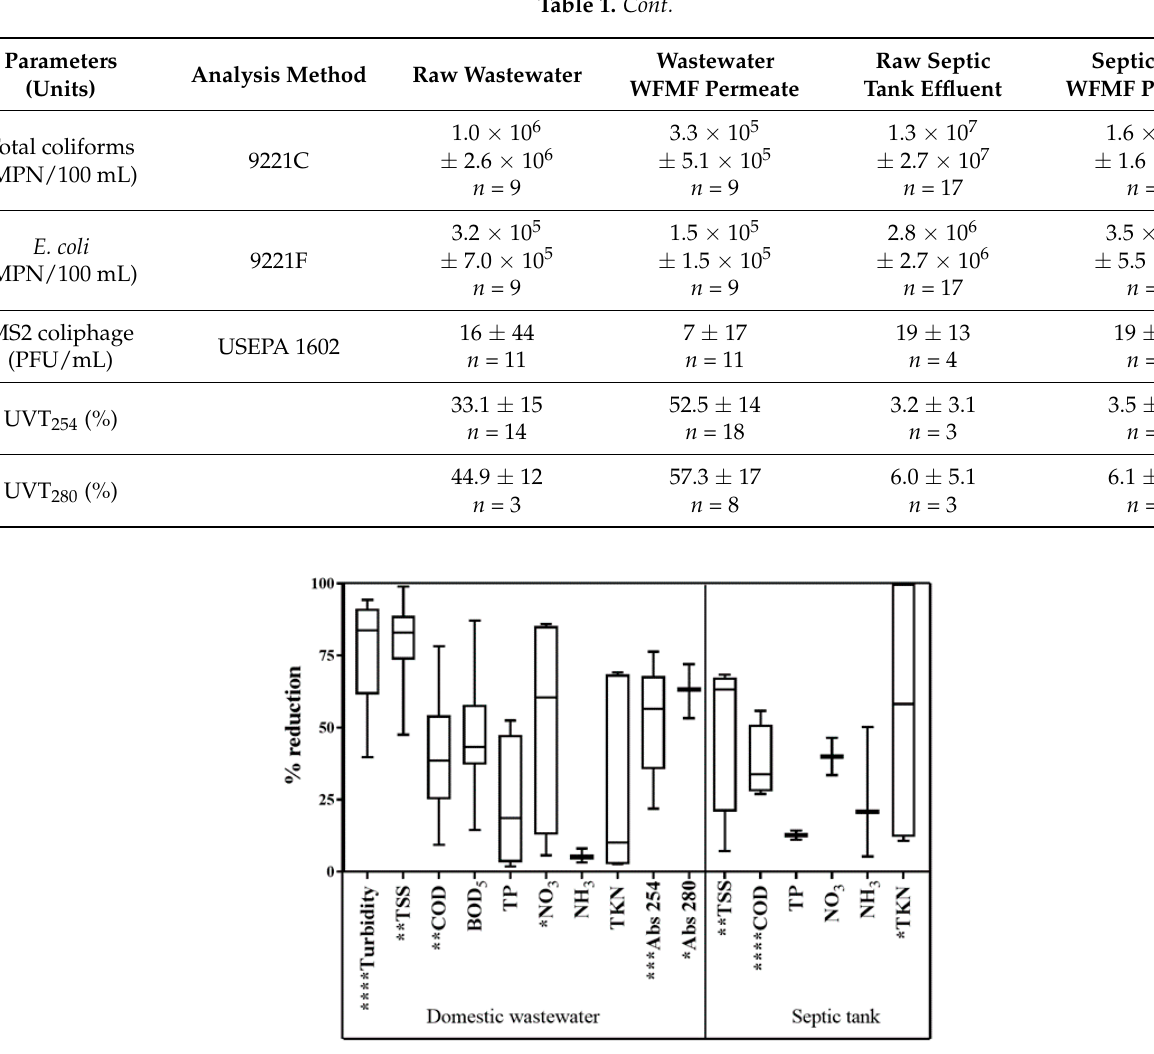
Figure 4. Box plots of WFMF removal efficiencies for treatment of AIT domestic wastewater and conventional septic tank effluent. Removal calculations included only influent and effluent data collected on the same day. Boxes and whiskers represent median and minimum to maximum values as well as 25th–75th percentiles. **** p < 0.0001, *** p < 0.001, ** p < 0.01, * p ≤ 0.05, no asterisk means no significant difference between influent and effluent data.